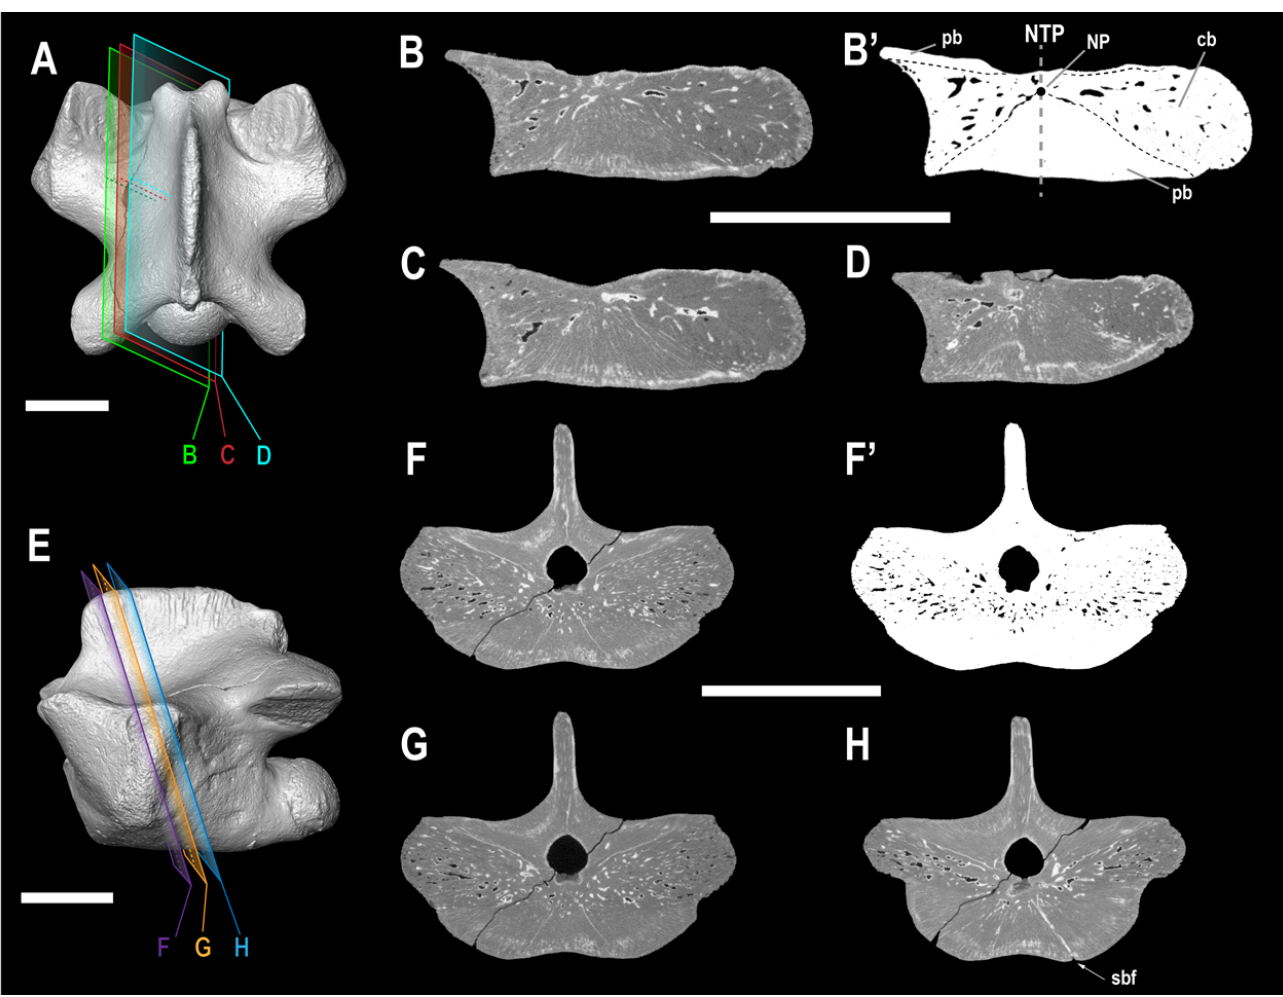
Figure 4. Computed scanning slices of ALG 200, holotype of Carentonosaurus algorensis sp. nov., from the uppermost middle to lowermost upper Cenomanian site of Algora (Guadalajara Province, Central Spain). The 3D models show the virtual slices taken for ALG 200 in longitudinal ( A ) and transversal ( E ) sections. The same sections, in the YZ ( B – D ) and in the XY ( F – H ) axes, were obtained in Avizo 7.1. ( B’ , F’ ), binary transformed images of a representative longitudinal ( B ) and transversal ( F ) section used for the compactness analyses in ImageJ and BonePro fi leR. Scale bars: 5 mm ( A , E ) and 10 mm ( B – D , F – H ).